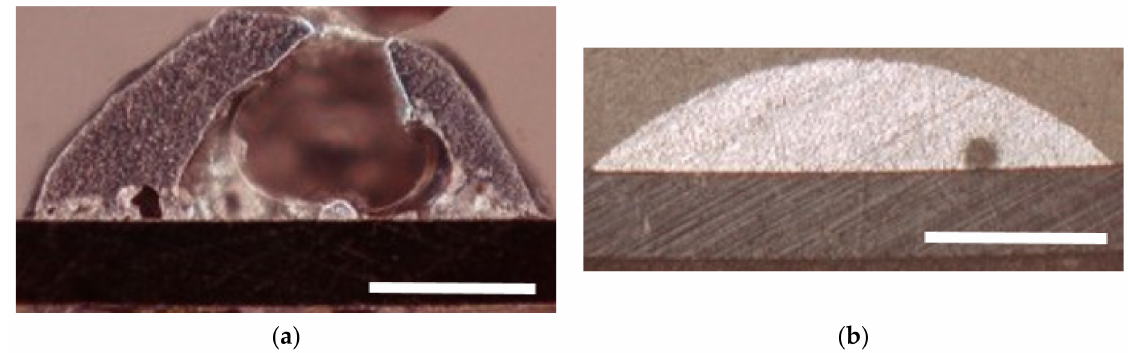
Figure 10. Side view of the deposited droplet printed at substrate temperature of ( a ) 25 ◦ C and ( b ) 150 ◦ C. Scale bar = 250 µ m.